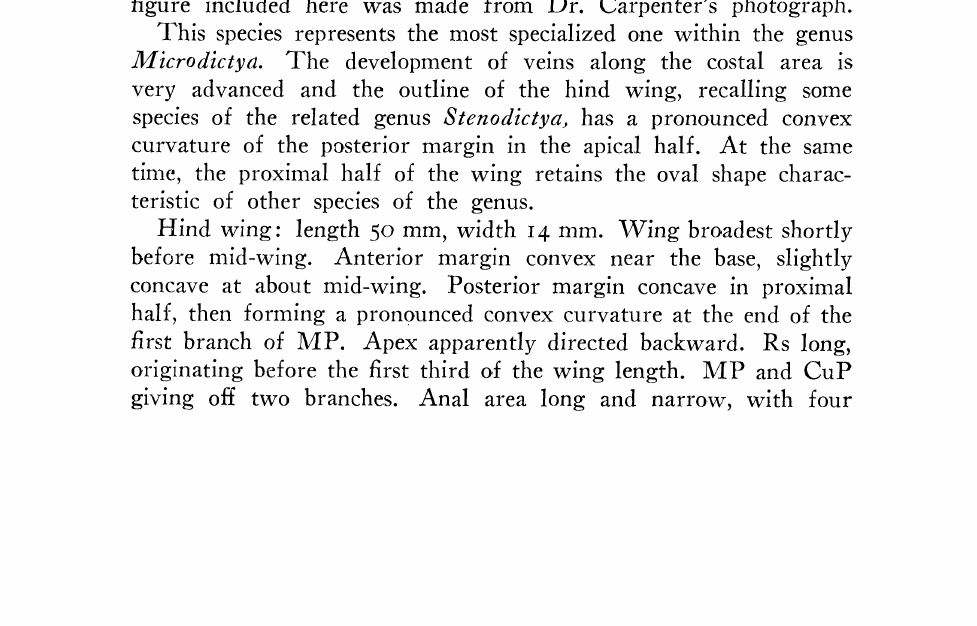
Figure 74. Microdictya aillanti Brongniart; specimen 22-12; fore wing. Holotype. Figure 75. Microdictya vaillanti Brongniart; specimen 22-5; fore wing. (Type of Stenodictya gaudryi Brongniart). Microdictya villeneuvei Meunier Figure 77 .Microdictya illeneuvei Meunier, 1908: 245, fig. 1; Meunier, 1908: